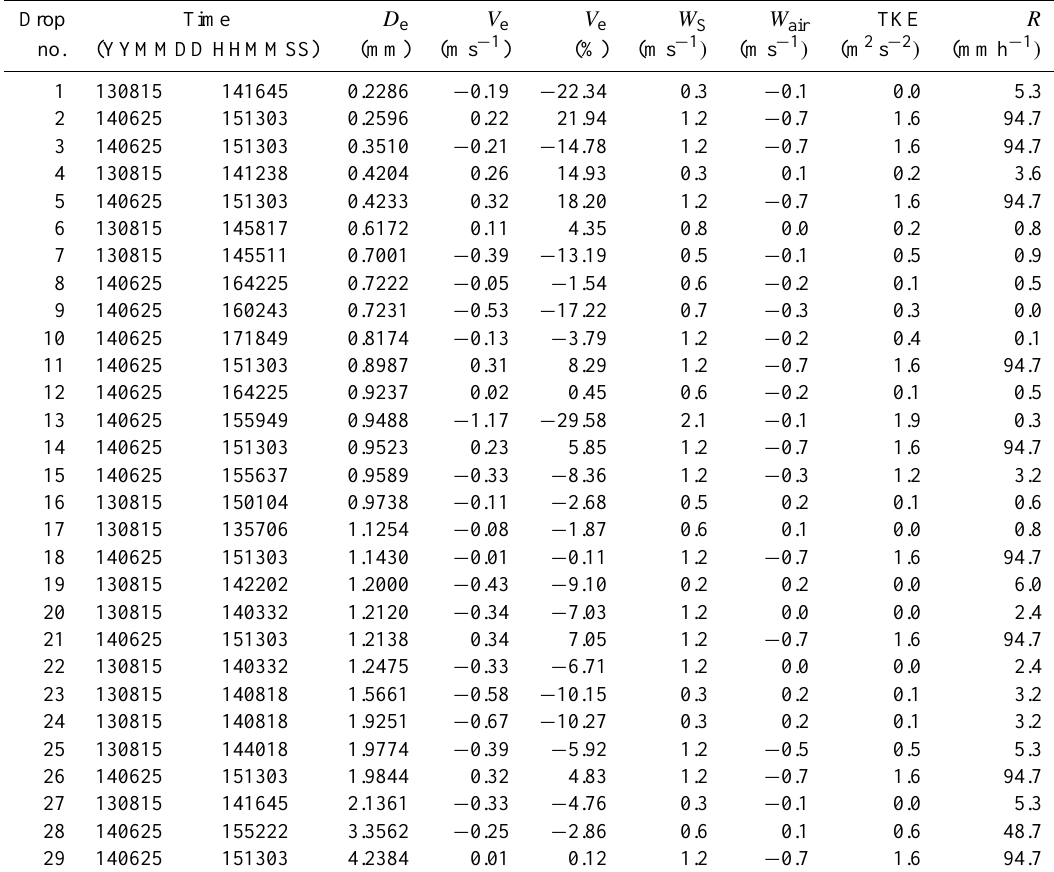
Table 1. Velocity deviations (i.e., V e ) of 29 analyzed drops collected from the outdoor experiments and ambient conditions including hor- izontal wind speed ( W S ) , vertical air motions ( W air ) , turbulent kinetic energy (TKE), and rainfall rate ( R) corresponding to each analyzed drop. Rain rates were measured by the Vaisala weather transmitter